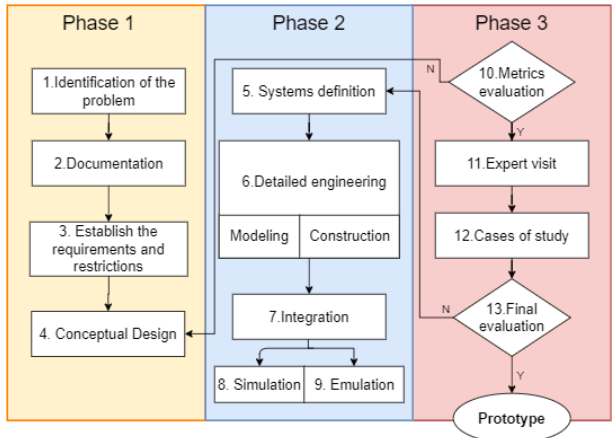
Figure 1. Diagram that explain the